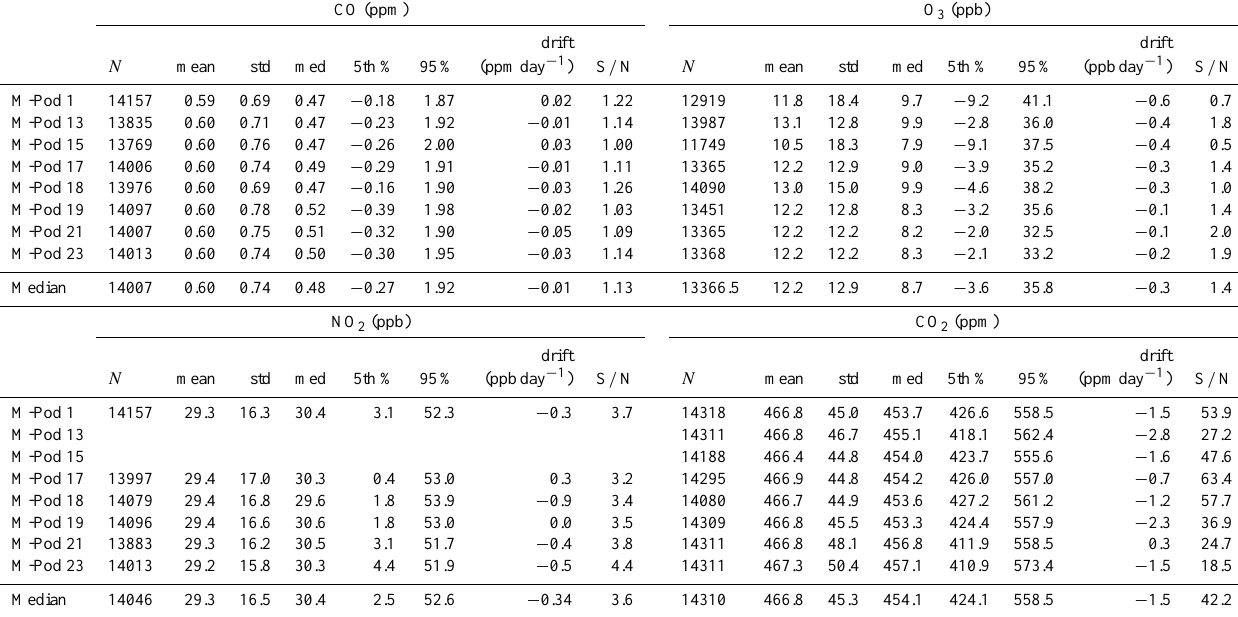
Table 1. Collocation calibration summary statistics for December collocation using the linear model from Eq. (3). CO (ppm)